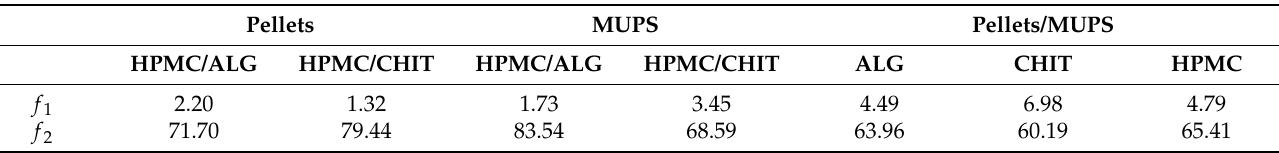
Table 7. The difference factor ( f 1 ) and the similarity factor ( f 2 ) comparing the reference ( R ) versus the tested ( T ) formulation ( R / T